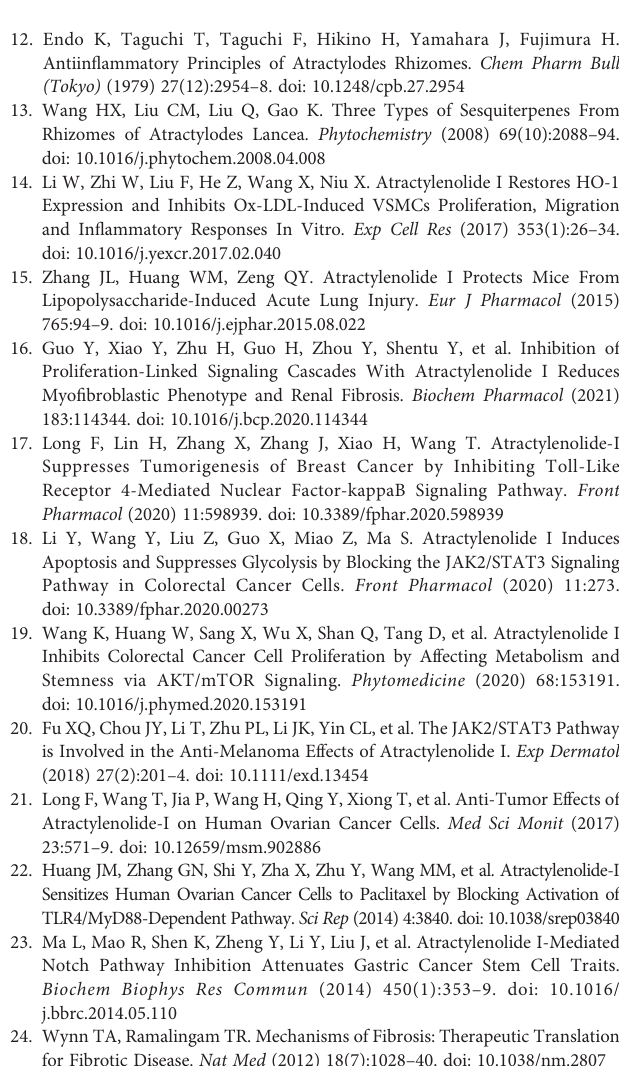
Supplementary Figure 2 | ATL-1 inhibits triple-negative breast cancer cell migration via CTGF. (A) Western blotting demonstrated that CTGF expression was knocked down in MDA-MB-231 and HS578T cells. Wound healing (B) and transwell migration (C) assays showed that the reductions in MDA-MB-231 and HS578T cell migration induced by ATL-1 were attenuated by sh-CTGF. Three technical replicates were performed for each of the three biological replicates. Mean ± SD, ** p < 0.01, *** p < 0.001 by Student ’ s t test. Supplementary Figure 3 | The effects of recombinant CTGF (rCTGF) and ATL-1 on the transformation of fi broblasts into CAFs in co-culture systems. (A, B) qRT- PCR demonstrated that treatment with different concentrate of rCTGF in the co- culture system for 48 hrs had different effect on the mRNA levels of CAF markers (FAPand a -SMA)compared withnorCTGF treatment. (C) qRT-PCRdemonstrated that treatment with 50 m M ATL-1 in the co-culture system for 48 hrs downregulated the mRNA levels of CAF markers compared with no ATL-1 treatment. Three technical replicates were performed for each of the three biological replicates. Mean ± SD, * p < 0.05, ** p < 0.01, *** p < 0.001 by Student ’ s t test. Supplementary Figure 4 | ATL-1 increased the sensitivity of TNBC cells to paclitaxel by downregulating the expression of CTGF in fi broblasts. CCK8 (A) assay showed the growth-inhibiting effects of paclitaxel on MDA-MB-231 and HS578T cells cultured alone ( – ) or co-cultured with fi broblasts with or without ATL-1